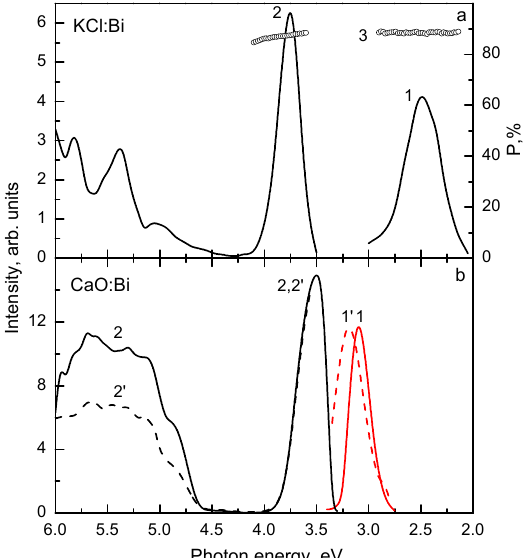
Figure 8. Emission (curves 1,1’), excitation (curves 2,2’), and polarization (curve 3) spectra of ( a ) KCl:Bi and ( b ) CaO:Bi at 4.2 K. In ( a ), E exc = 3.7 eV (curves 1,3) and E em = 2.6 eV (curves 2,3). In ( b ), E exc = 3.5 eV, slow component (curve 1), E exc = 3.6 eV, fast component (curve 1’), E em = 3.1 eV (curve 2), and E em = 3.3